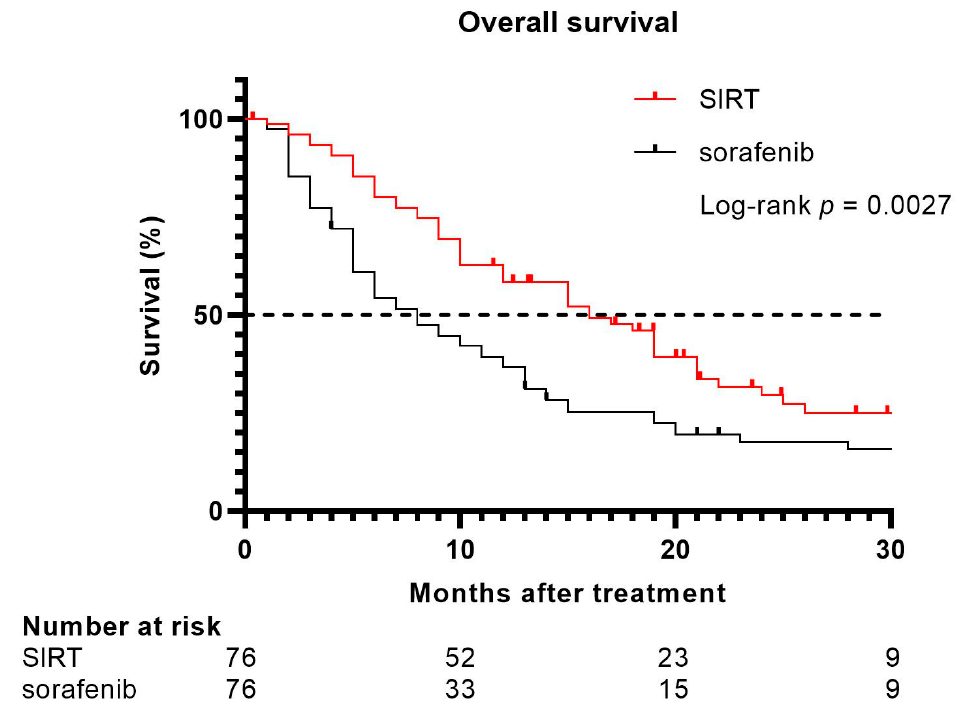
Figure 4. Overall survival in all patients treated with SIRT matched with patients treated with sorafenib.